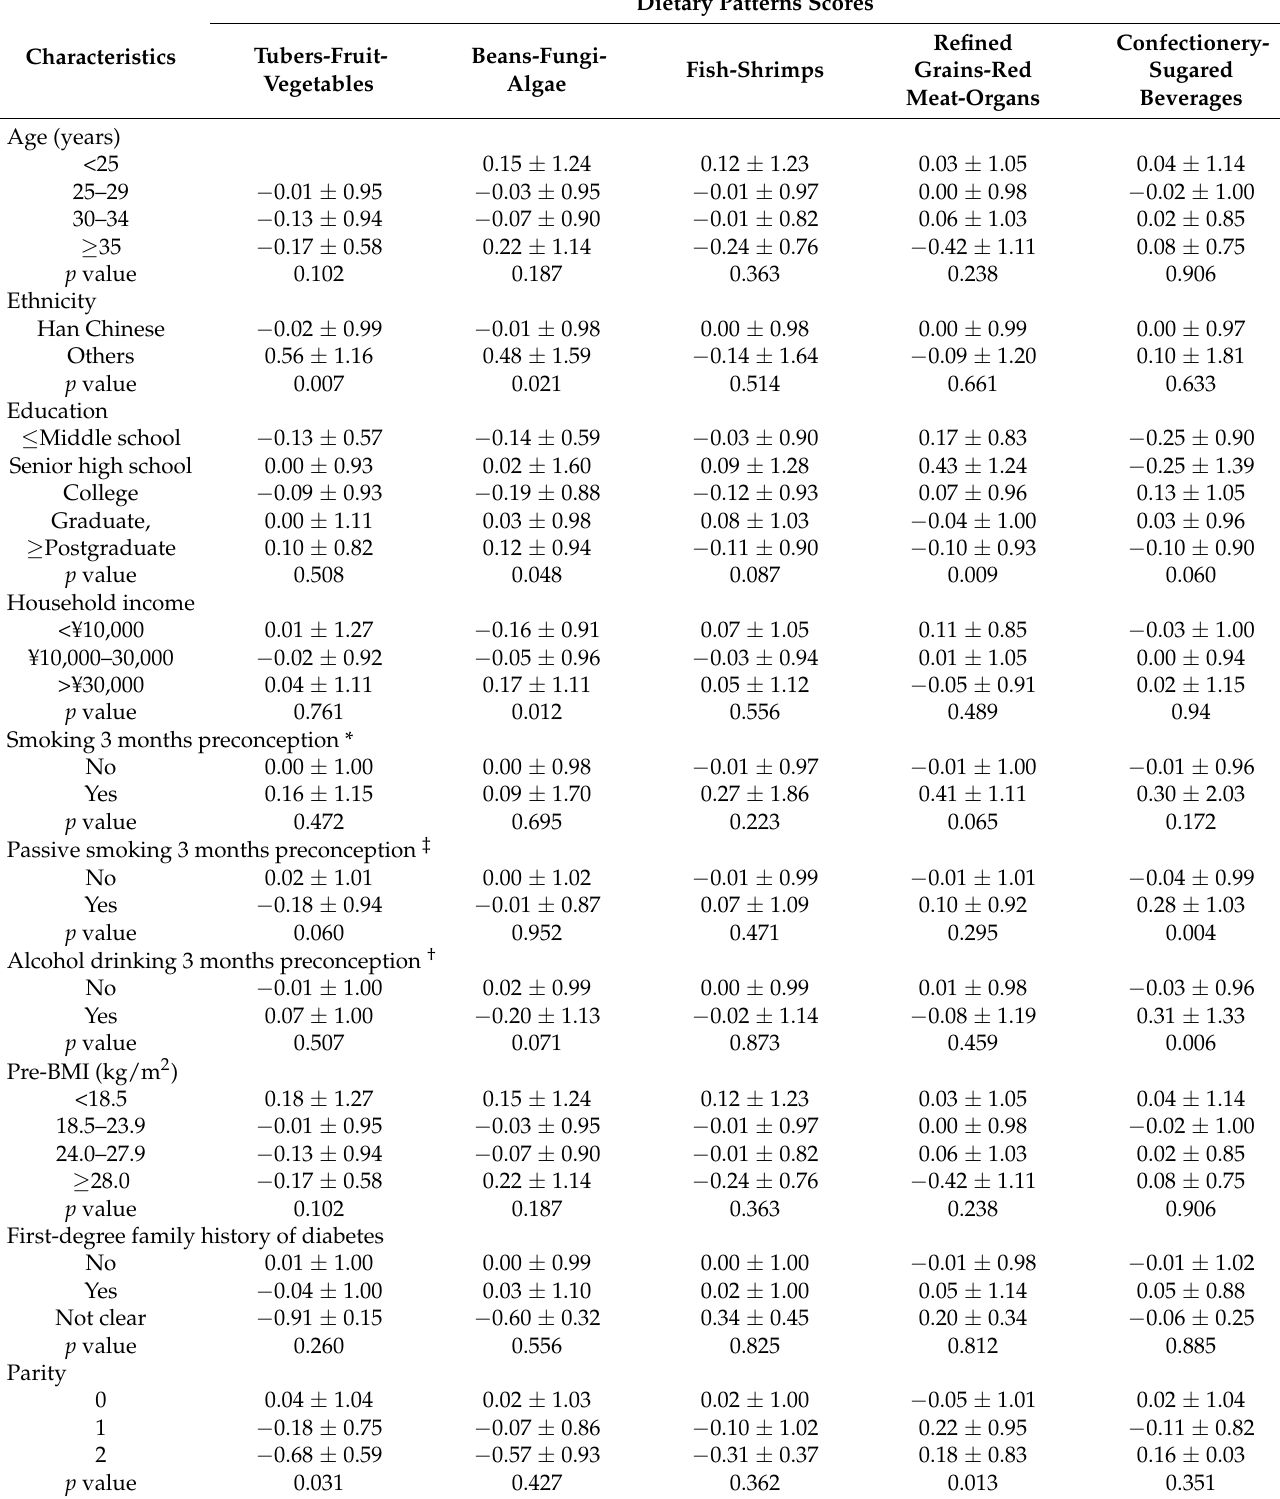
Table 3. Dietary pattern scores, stratified by maternal characteristics, in 840 pregnant women in Shanghai,